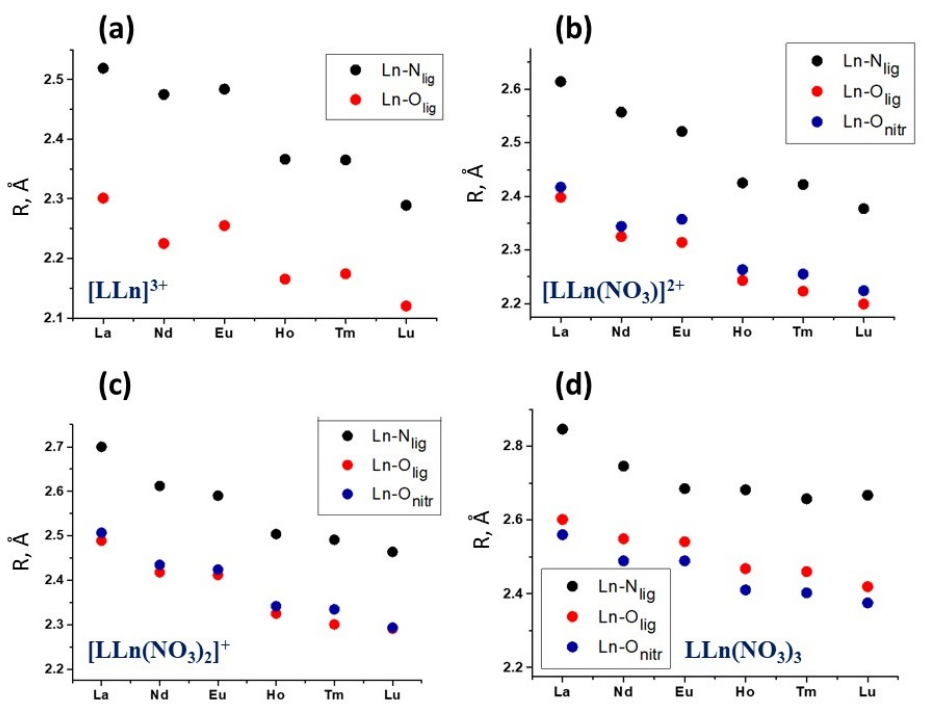
Figure 5. Average calculated bond lengths in the ( a ) [ L2 Ln] 3+ , ( b ) [ L2 Ln(NO 3 )] 2+ , ( c ) [ L2 Ln(NO 3 ) 2 ] + and ( d ) L2 Ln(NO 3 ) 3 complexes.